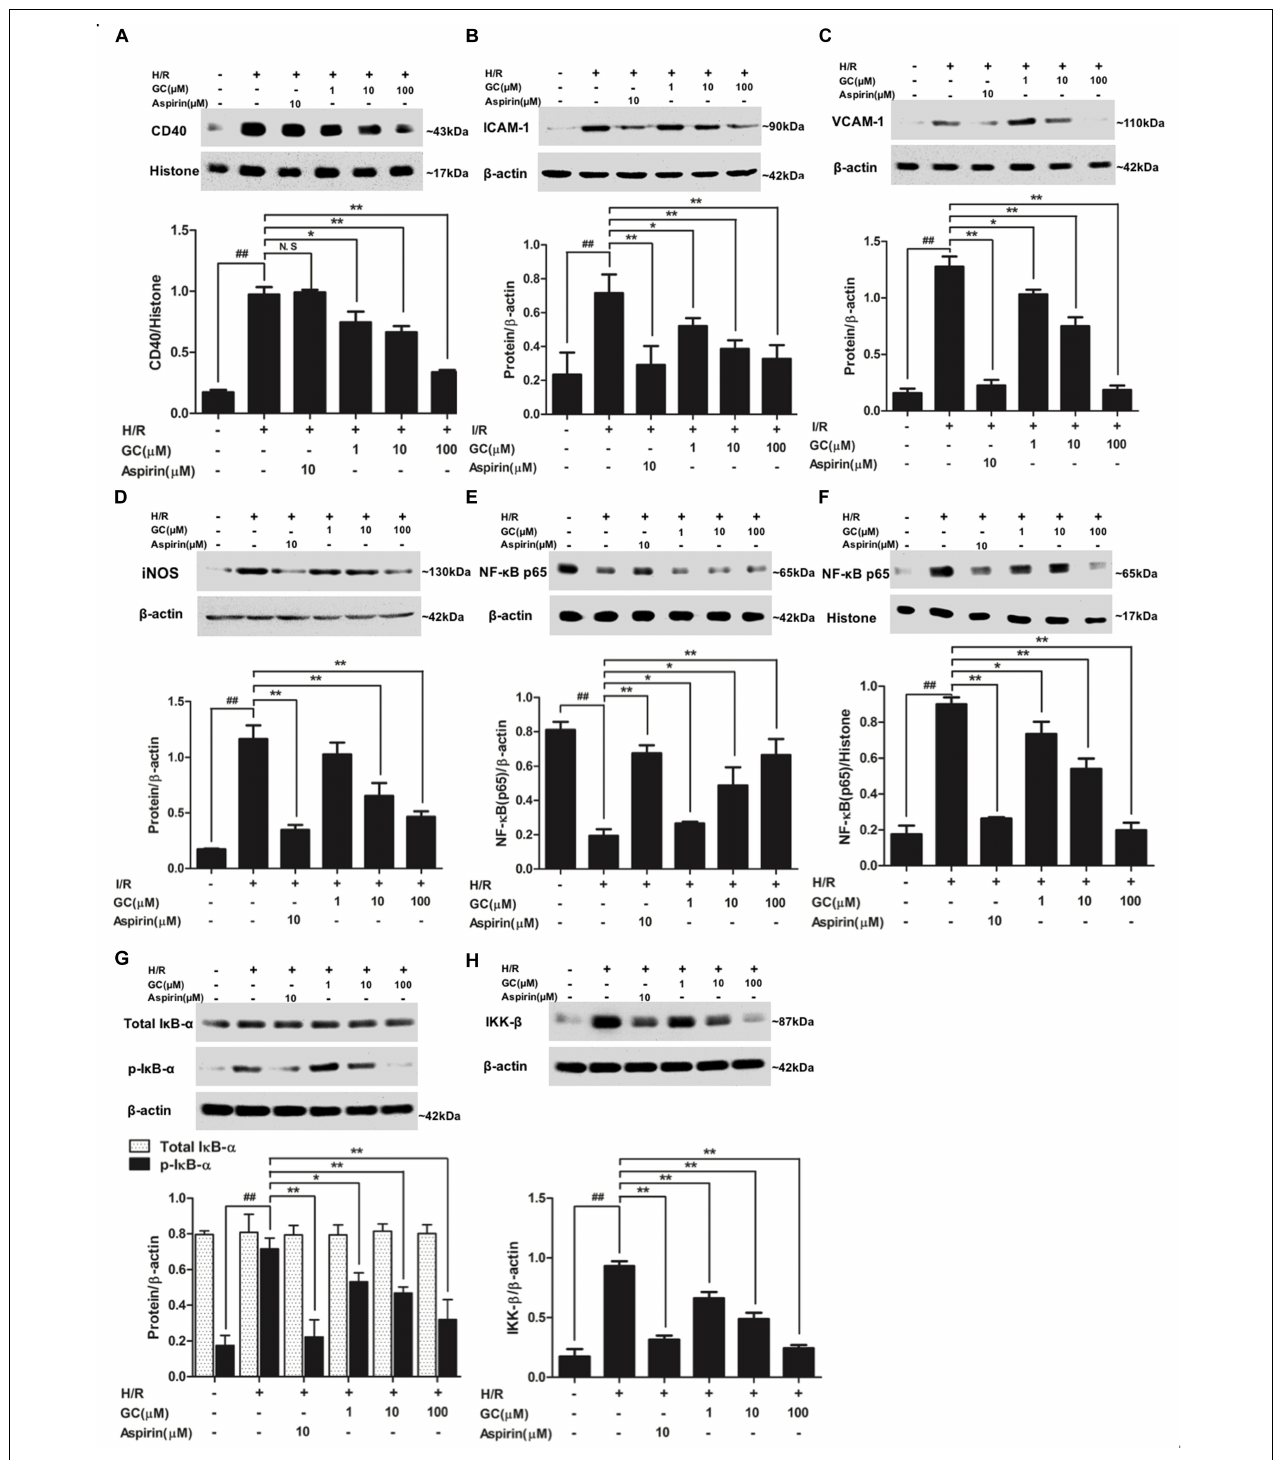
FIGURE 7 | Effects of GC on the expressions of CD40, ICAM-1, VCAM-1, iNOS, NF- κ B p65, p-I κ B- α and IKK- β by Western blot after H/R procedure. (A) GC decreased the expression of CD40. (B) GC decreased the expression of ICAM-1. (C) GC decreased the expression of VCAM-1. (D) GC decreased the expression of iNOS. GC blocked the translocation of NF- κ B p65 from cytosolic (E) to nuclear (F) . (G) GC down-regulated the expression of p-I κ B- α . (H) GC decreased the expression of IKK- β . CD40, ICAM-1, VCAM-1, iNOS, p-I κ B- α and IKK- β proteins were measured in cytosolic extract. The NF- κ B p65 protein levels were assayed separately in cytosolic and nuclear extracts. Results were expressed as Protein/reference protein ratio. Data were expressed as mean ± SD of three independent experiments. ## P < 0.01 vs. control group; ∗ P < 0.05, ∗∗ P < 0.01 vs. H/R group.